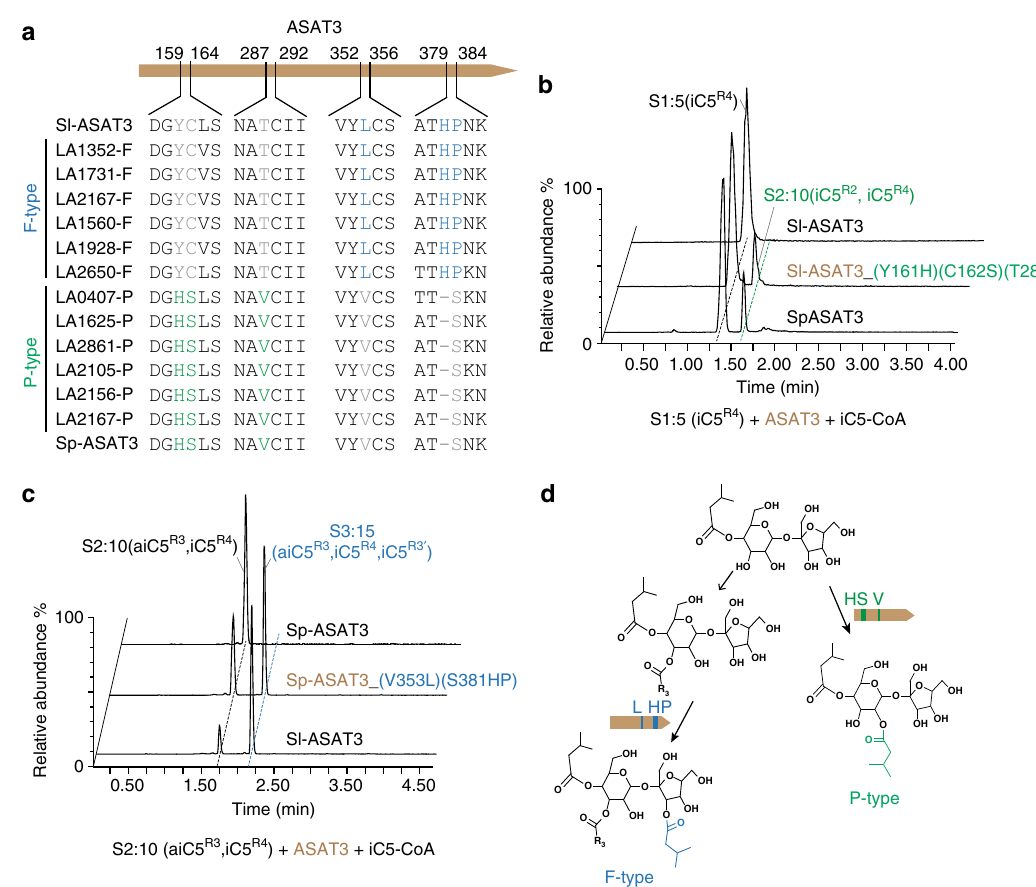
Fig. 5 Identi fi cation of residues that confer P-type activity to Sl-ASAT3 or F-type activity to Sp-ASAT3. a Amino acid sequences of ASAT3-P or -F alleles from different S. habrochaites accessions revealed residues that correlate with each enzyme type, and these are color coded. Blue amino acids are associated with F-type and green residues with P-type activity. b The results of in vitro assays performed with the two parental enzymes and the triple mutant created by site-directed mutagenesis of Sl-ASAT3 enzyme. The Sl-ASAT3 protein with three residue substitutions — Y161H, C162S, and T289V — produced the diacylsucrose product that has the same chromatographic retention time with the product of Sp-ASAT3 using S1:5 (iC5 R4 ) as the substrate. c The double amino acid position mutant Sp-ASAT3 — with V353L and S380HP — produced the triacylsucrose product that has the same chromatographic retention time with the product of Sl-ASAT3 using S2:10 (aiC5 R3 , iC5 R4 ) as the substrate. d Interpretation of the results of parts b and c , showing the key amino acids associated with F- and P-type ASAT3 enzyme